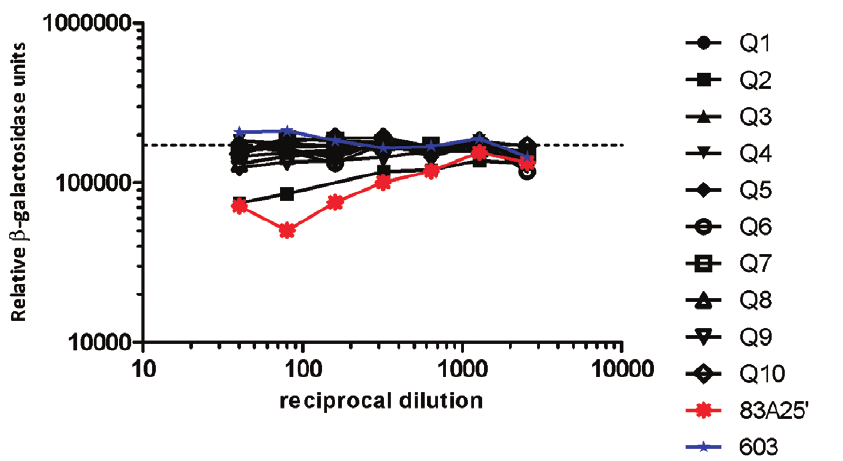
Figure 1. Detection of XMRV neutralising antibodies in human sera. Infectivity of XMRV after incubation with patient serum or monoclonal suspension. Infectivity (measured as relative b -galactosidase units) is plotted against the reciprocal of the serum dilution (black symbols) or monoclonal suspension (blue data points, monoclonal 603, negative control; red data points, 83A25 9 , positive control). Dashed line indicates level of infectivity in the absence of serum/monoclonal. Q1–10 are patient designations. Q2 exhibits neutralisation.